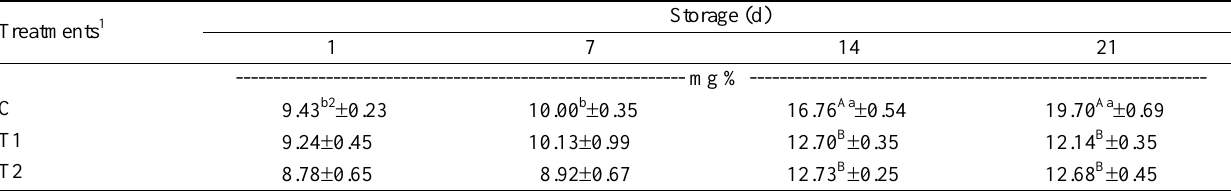
1 C: ziplock bag packaging, T1: vacuum packaging, and T2: MAP (CO 2 A-B Means  SD with different superscripts in the same column differ significantly at p<0.05. a-b Means  SD with different superscripts in the same row differ significantly at